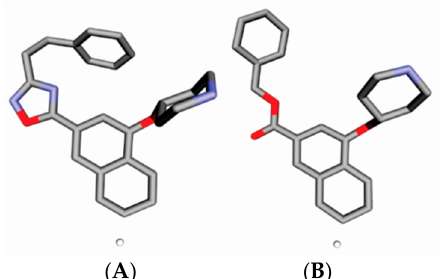
Figure 9. Representation of GCOD-7 (0,6,2, any) (white sphere) and ( A ) compound 62 , and ( B ) compound 59 , and the gray and red representations are carbons and oxygen atoms.